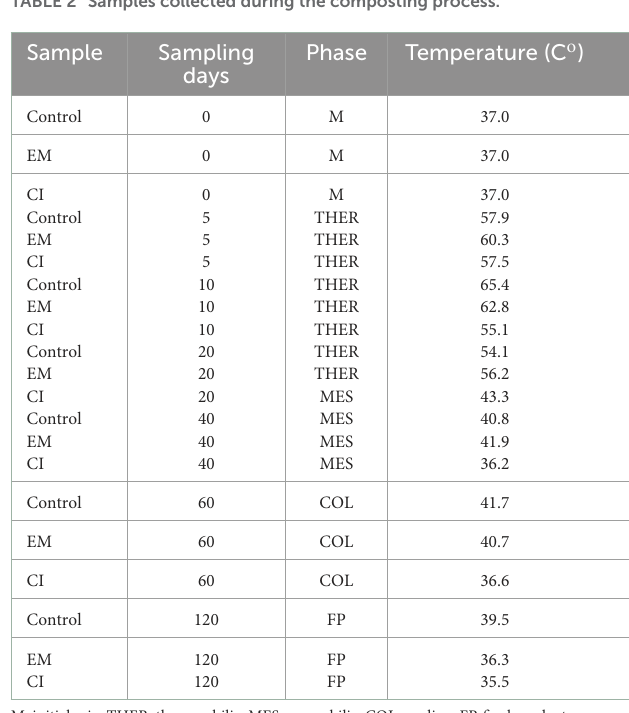
TABLE 2 Samples collected during the composting